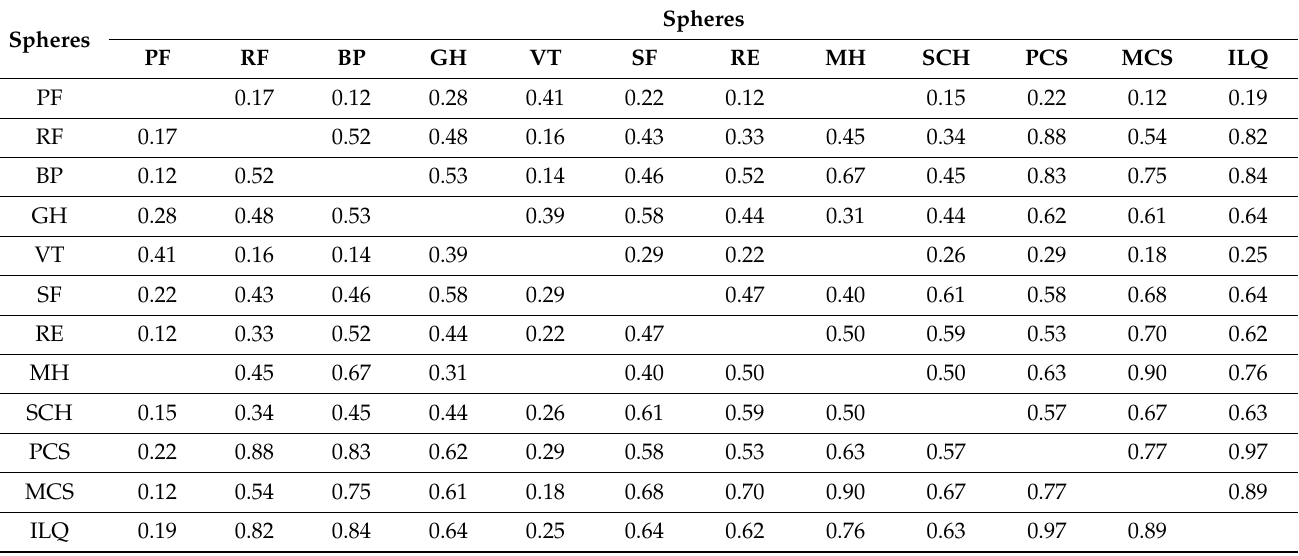
Table A2. Correlations of SF-36 spheres for the age group of 66–70 years (Spearman’s r coefficient). Spheres